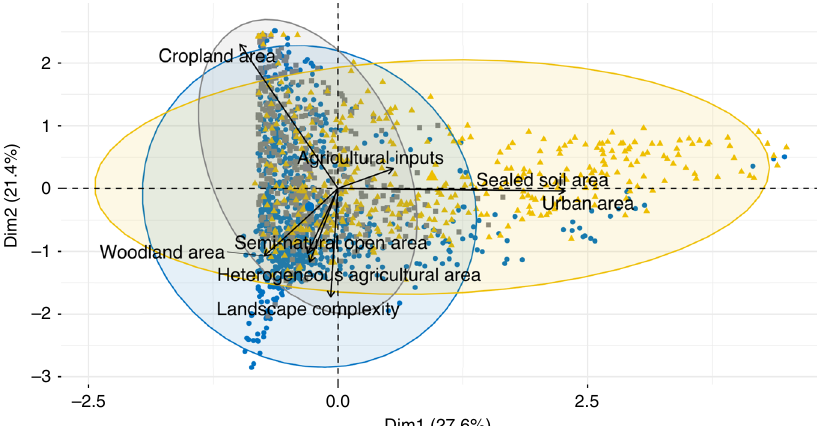
Fig. 2 Principal component analysis performed on the landscape variables describing the study sites. Each point corresponds to a site and a buffer size, colors correspond to the different taxa and each ellipse contains 95% of the sites of the corresponding taxa. Each axis is a linear combination of the variables describing the landscapes. Each arrow indicates the contribution to the two PCA axes of each variable describing the landscape. Gray squares correspond to sites with bat communities, blue circles to sites with bird communities, and yellow triangles to sites with butter fl y communities.